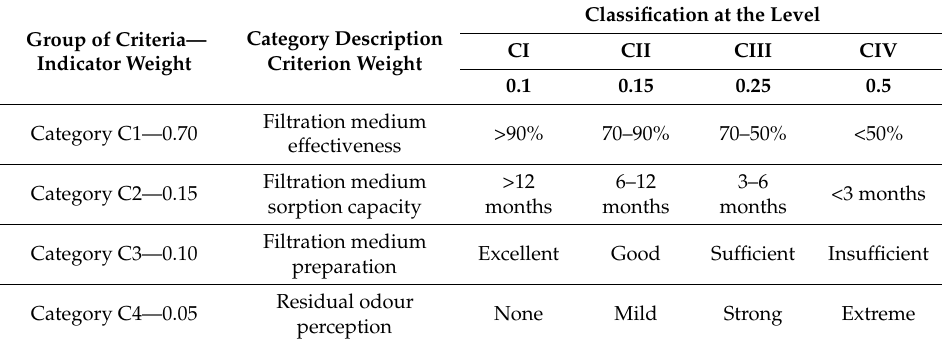
Table 6. Proposed evaluation criteria of filtration